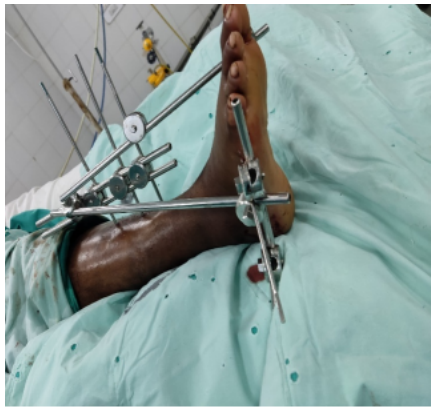
Figure 3. final framework of external fixator